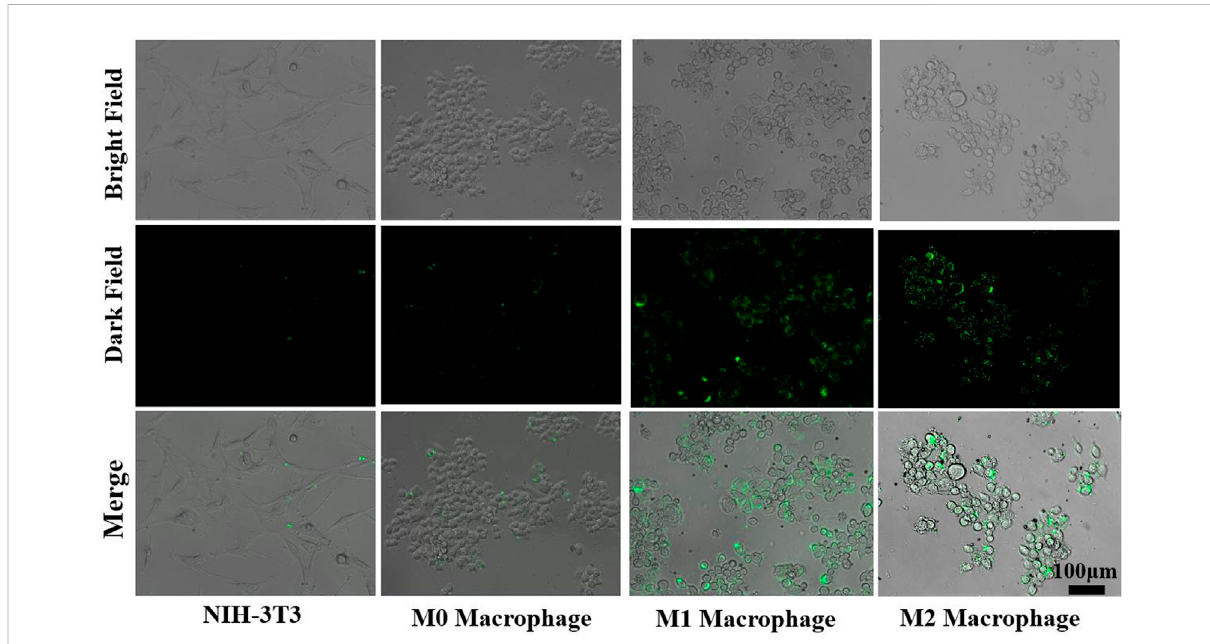
FIGURE 6 Adhesion of Cur – AceKGM NPs with NIH3T3 cell and RAW264.7 with different phenotypes; scale bar = 100 μ m.